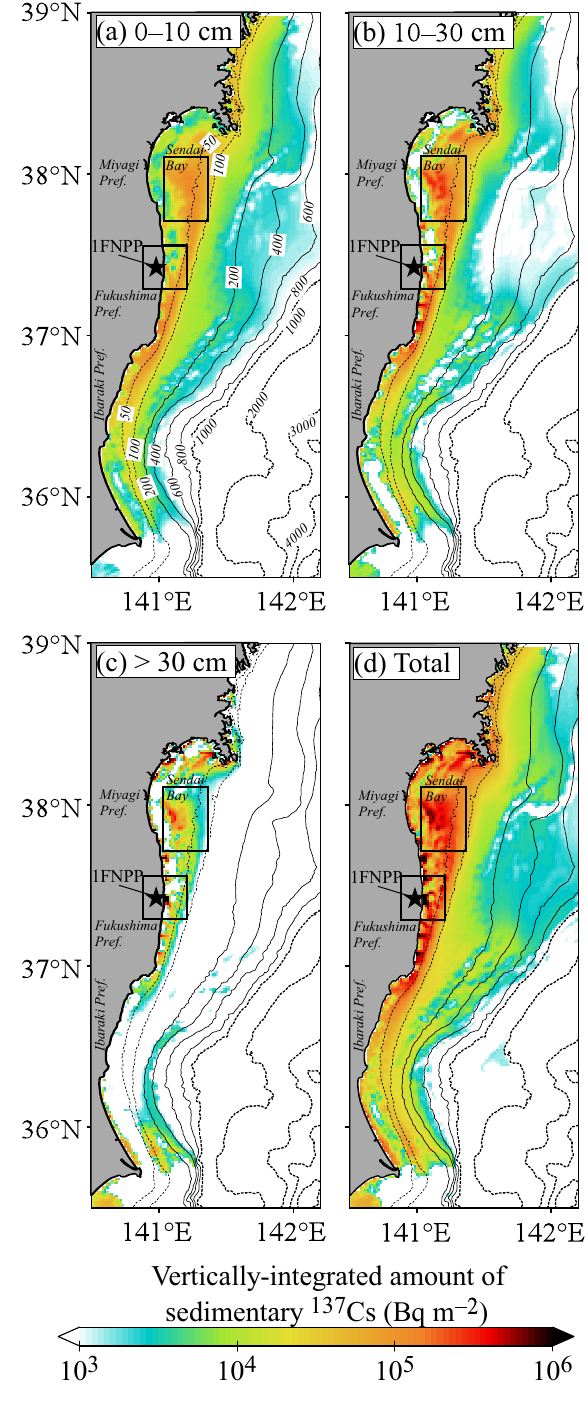
Figure 9. Simulated vertically integrated amounts of sedimentary 137 Cs at the end of 2011 in the (a) surface (0–3cm) layer, (b) upper 10–30cm layer, (c) >30cm deep layer, and (d) vertical-total sedi- ment. Black star indicates location of 1FNPP. Contours show water depth (m) according to JTOPO30 (MIRC). Rectangular regions are cited in Sect.